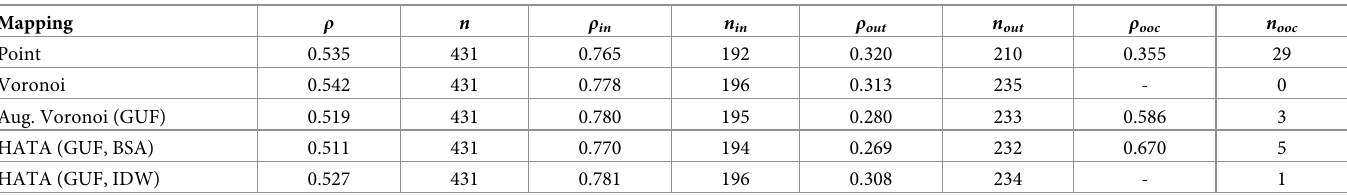
Table 7. Correlation with true unemployment rate and sample size in Senegal.